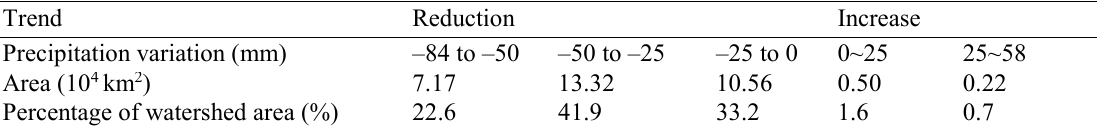
Table 3 Spatial variation of precipitation in